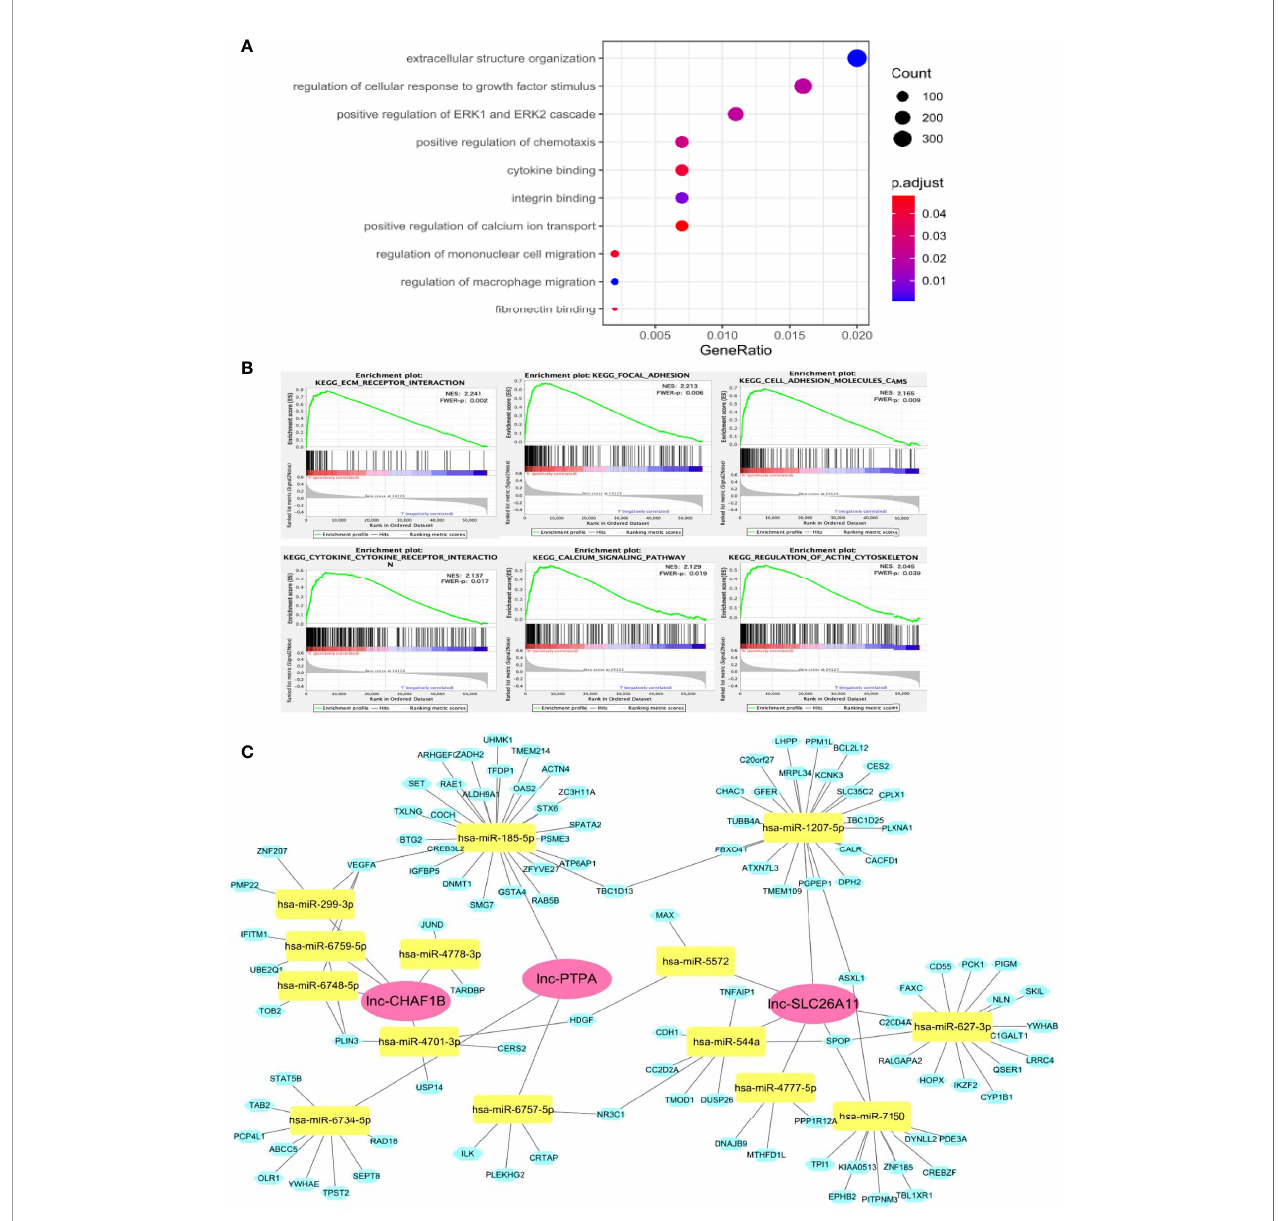
FIGURE 4 | Potential functions of the immune-related lncRNA signature. (A) GO analysis showed that these lncRNAs might participate in many cancer development processes. (B) GSEA assay indicated that a number of genes were enriched in cancer progression and immune-associated pathways. (C) ceRNA network of the lncRNA-signature. The red diamond blocks indicated the lncRNA, the green triangle blocks indicated miRNAs that can be potentially sponged by the lncRNAs. The blue circle blocks indicated the potential mRNA targets of each